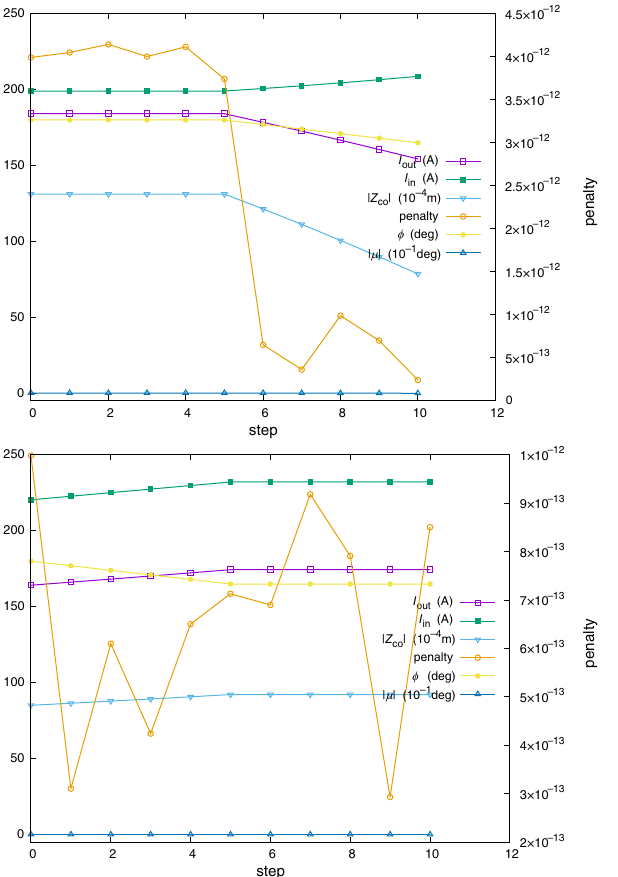
FIG. 33. Components of the stable spin precession direction, and spin tune, over the snake power supply ramp. Top: at IP6; bottom: at the p-C polarimeter, location of the polarization measurement in this experiment. Data were obtained from the one-turn spin matrix.